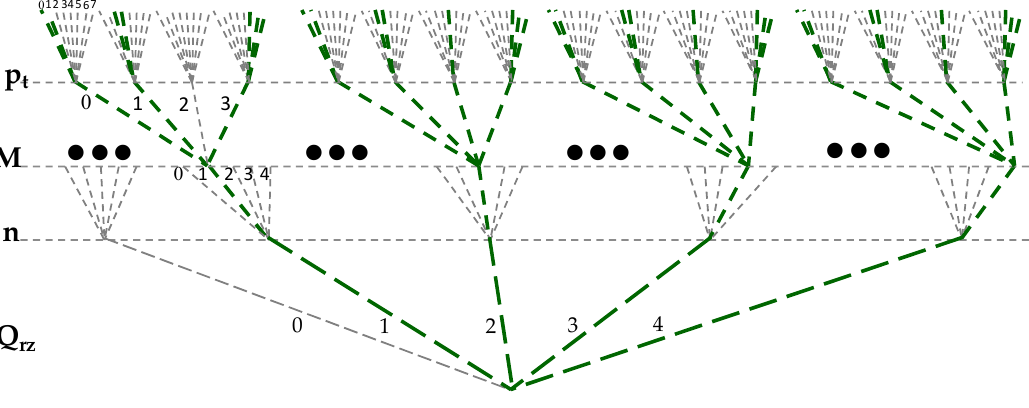
Figure 2. Volumetric efficiency η v . Table 2. Logically coded data for η v . The data were from the green tree branches in Figure